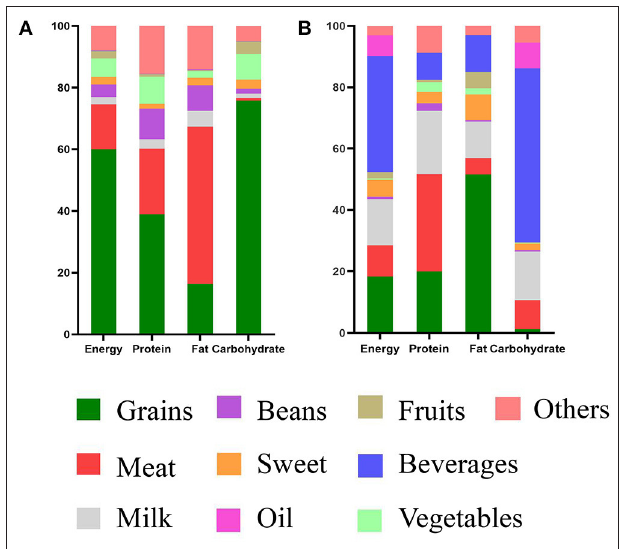
FIGURE 4 | Food sources of energy and macronutrients among inhabitants in high altitude and 2011CHNS. (A) Nutrient intakes of 2011CHNS, (B) nutrient intakes of inhabitants. The nutrition of participants consumed are plotted on the X -axis, and percentage contribution of the nine major food groups are plotted on the Y